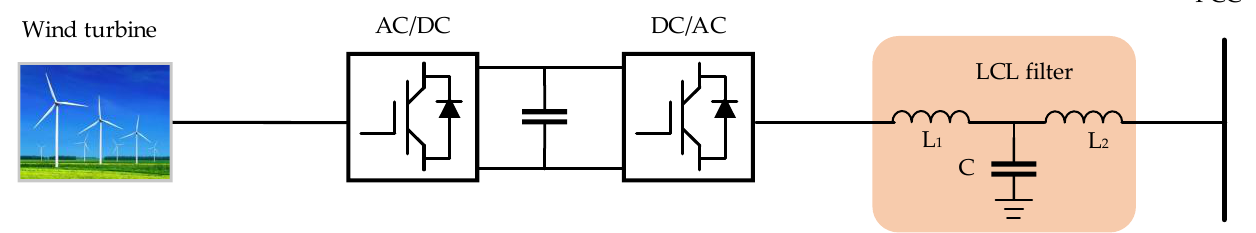
Figure 19. Schematic diagram of wind power generation VSG.